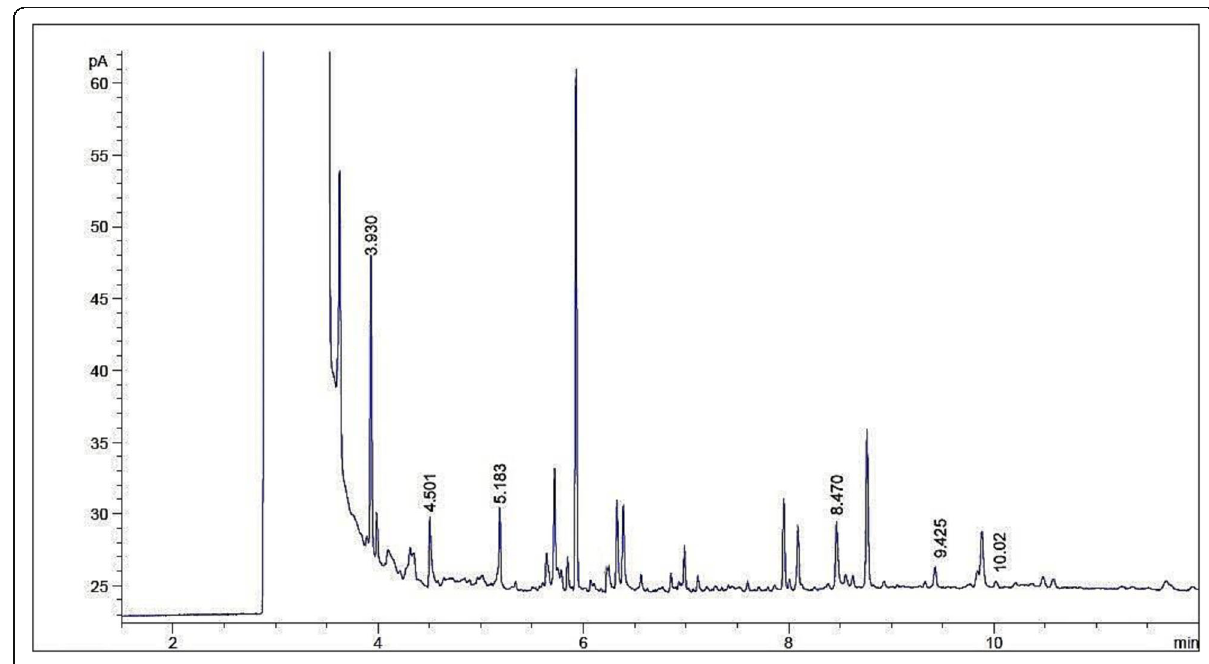
Fig. 5 Six chromatogram peaks chosen for